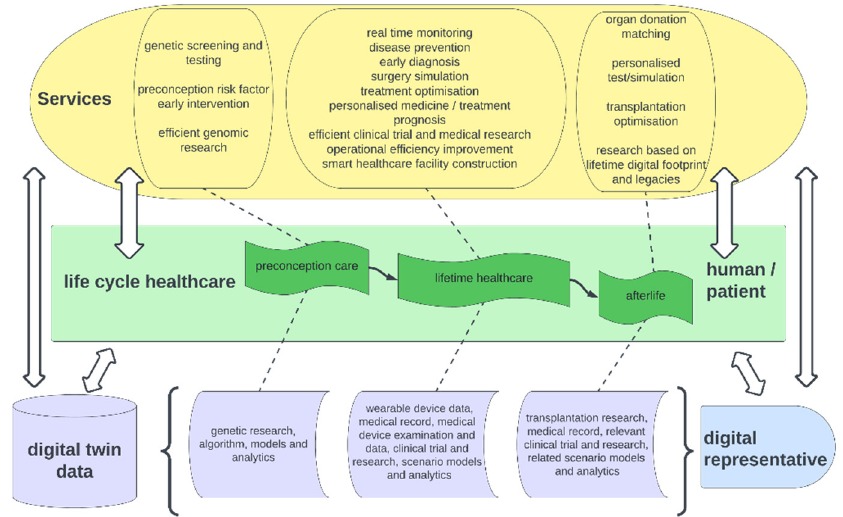
Figure 2. Digital twin model in